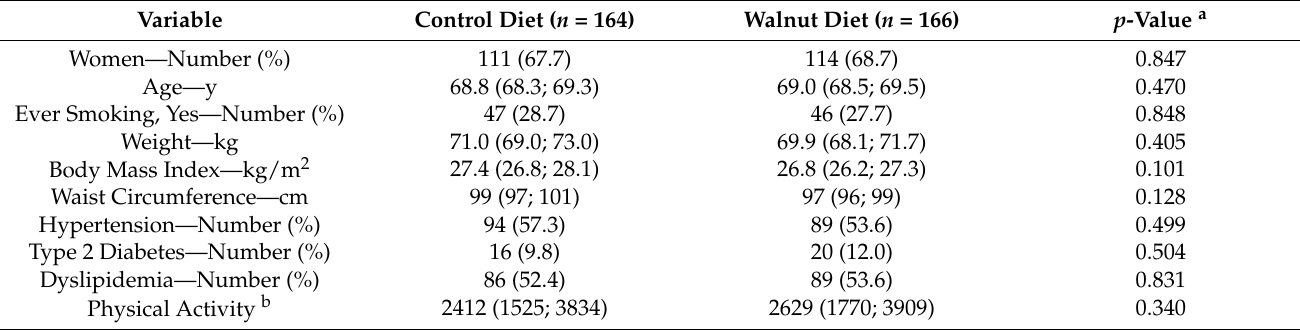
Table 1. Baseline characteristics of the study’s population by intervention